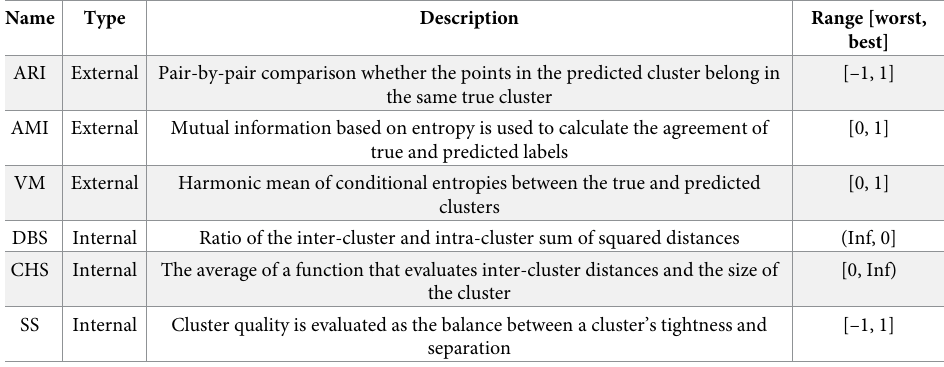
Table 1. An intuitive description for each metric, its type and its